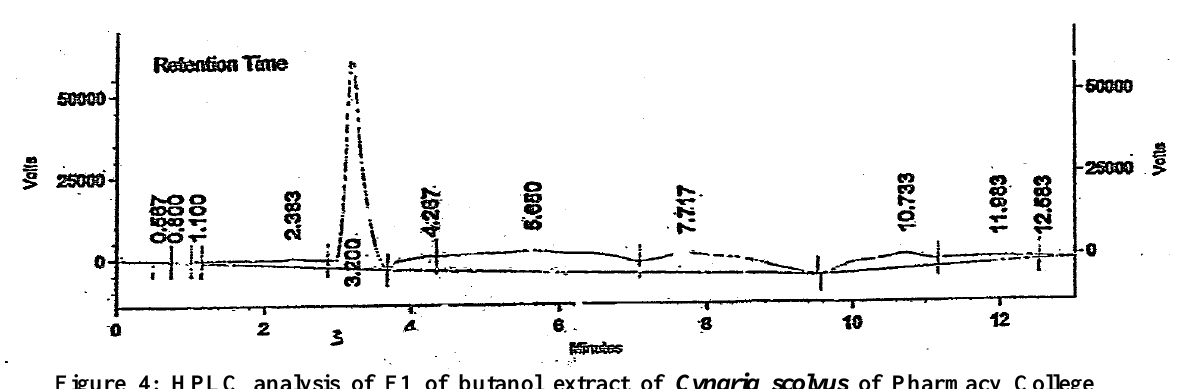
Figure 4: HPLC analysis of F1 of butanol extract of Cynaria scolyus of Pharmacy College Baghdad University. Fraction of the column № 1,2,3,4,5.